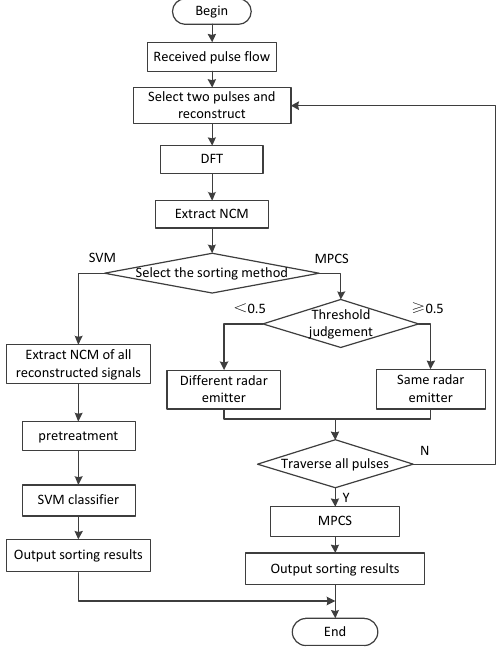
Figure 7. Sketch map of signal sorting based on NCM.